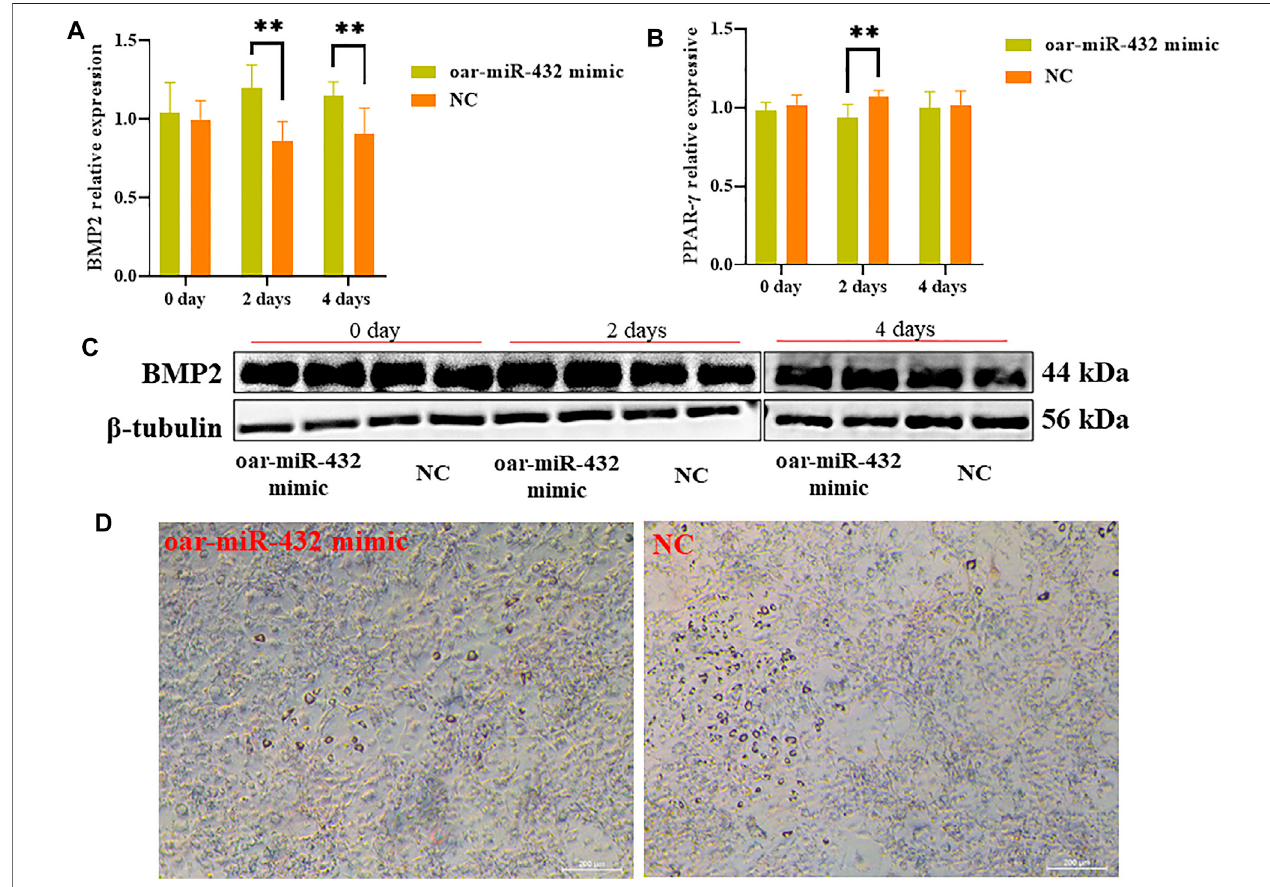
FIGURE 5 | Relative expression of BMP2 (A) and PPAR- γ (B) . (C) Oar-miR-432 mimic regulated the protein level expression of BMP2. (D) Oilred O staining when oar-miR-432 mimic in sheep preadipocytes after the maintenance differentiation